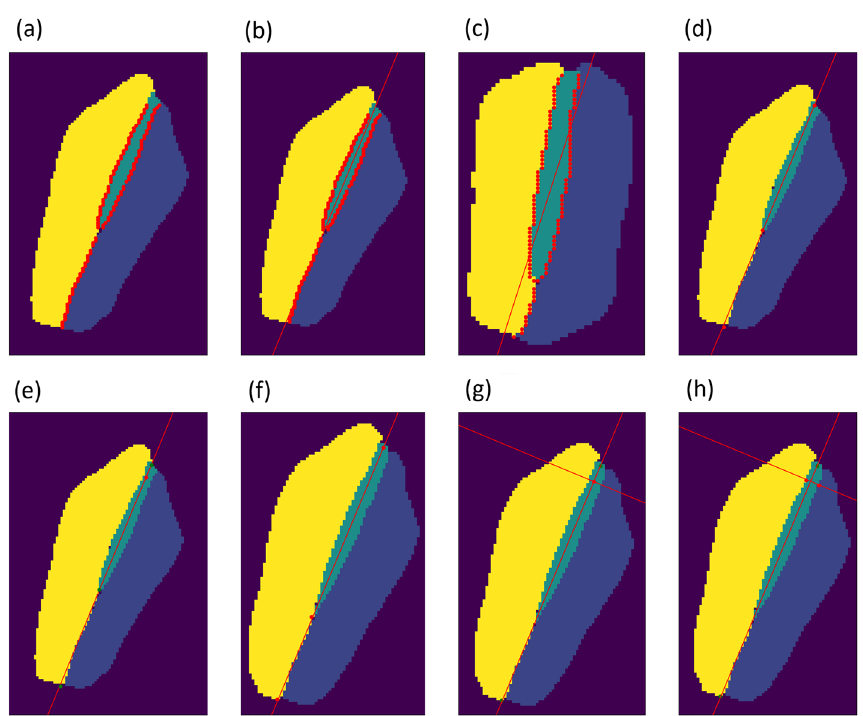
Figure 4. Image representations of the process of localizing a specific line on the glottis for quantification. ( a ) The image with the biggest opening, with points on the edge between the left and right vocal fold. ( b ) linear regression between the points on the edges, using an x over y regression. ( c ) Image of another patient using a y over x regression line. ( d ) Collision points for upper and lower borders are marked. ( e ) The length between the collision points is used to determine the 10% point from the rear of the glottis. ( f ) The algorithm loops through all segmented images and performs the same steps. ( g ) A perpendicular line is drawn at the 10% point from the rear of the glottis. ( h ) Points at the vocal fold edges are placed on the perpendicular line to determine the distance between them at the specific point on the